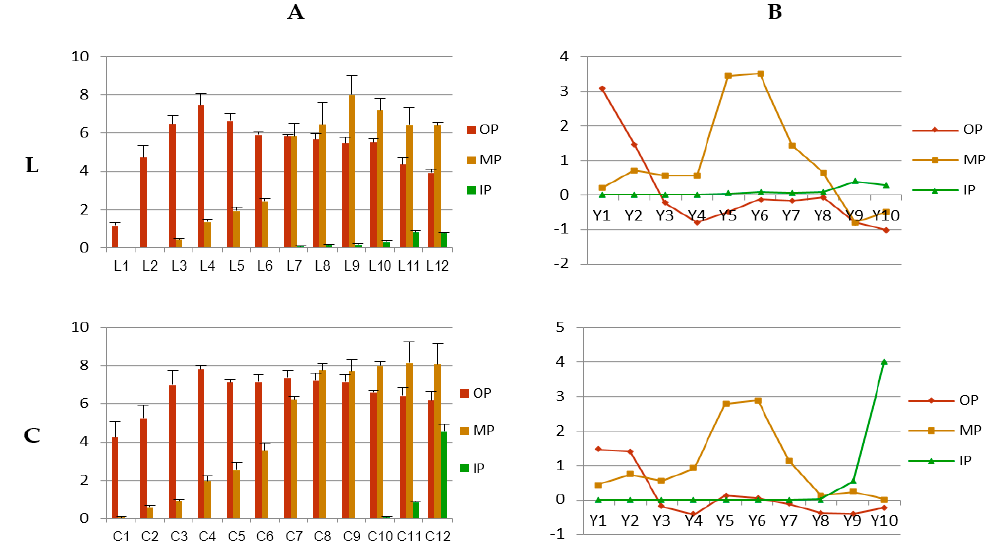
Figure 3. Anthocyanin content and corresponding model of change dynamics of petals of three layers at 12 development stages of both varieties. L: variety ‘Jiaoyan zhuanhong’; C: variety ‘Jiaoyan yanghong’; OP, MP and IP: outer, middle and inner layer of petals, respectively; ( A ) anthocyanin content measured using pH differential method and displayed with unit (mg 100g − 1 FW), L1-L12, C1-C12: measurements of petals at 12 development stages (Figure 1); ( B ) Model of Change Dynamics of anthocyanin where